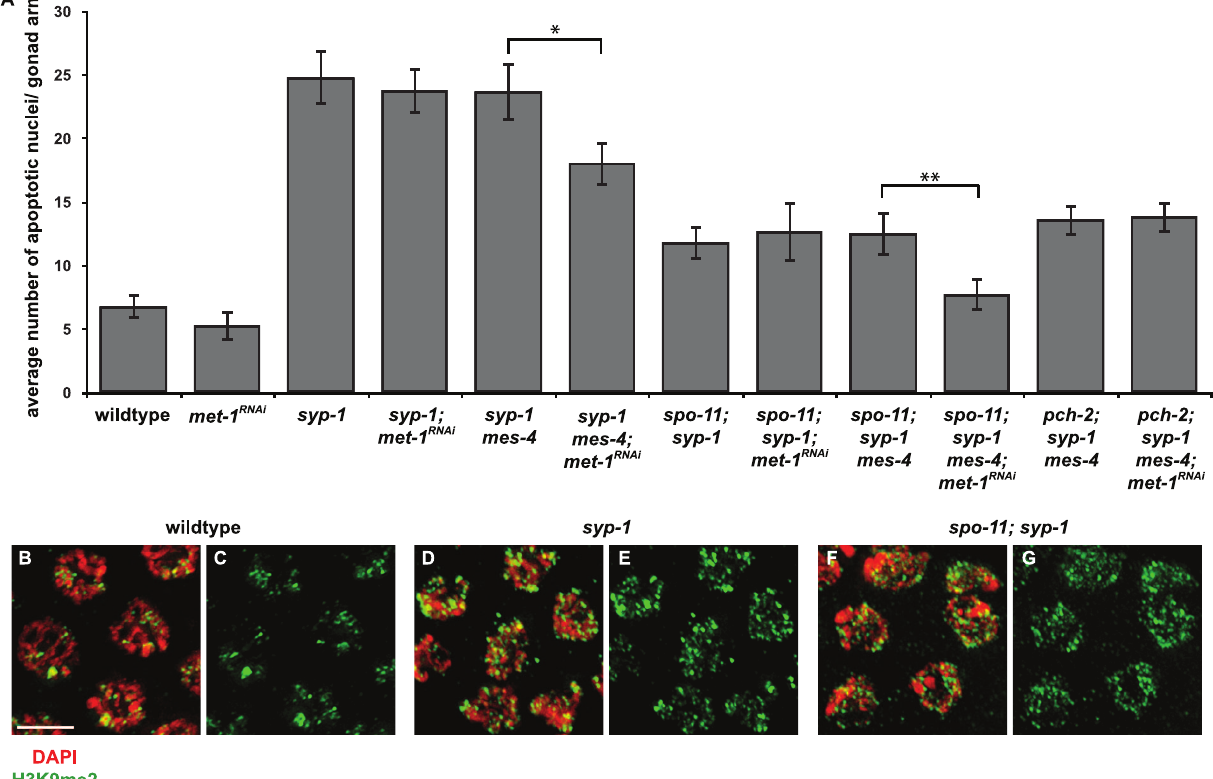
Figure 4. mes-4 and met-1 are redundant for synapsis checkpoint activation when all chromosomes are unsynapsed. A. Inactivation of both mes-4 (by mutation) and met-1 (by RNA interference) is required to reduce apoptosis in syp-1 and spo-11; syp-1 mutants but does not affect apoptosis in pch-2; syp-1 mutants. A * indicates a p value of , 0.05 and a ** indicates a p value of , 0.0001. Error bars indicate 2XSEM. B–G. Heterochromatin assembly occurs on unsynapsed chromosomes in syp-1 and spo-11; syp-1 mutants. Indirect immunofluorescence was performed on meiotic nuclei in wildtype, syp-1 and spo-11; syp-1 double mutants with an antibody against H3K9me2. Wildtype nuclei exhibit regions of enrichment or depletion while both syp-1 and spo-11; syp-1 mutants exhibit dispersed H3K9me2. Scale bar represents 4 microns.